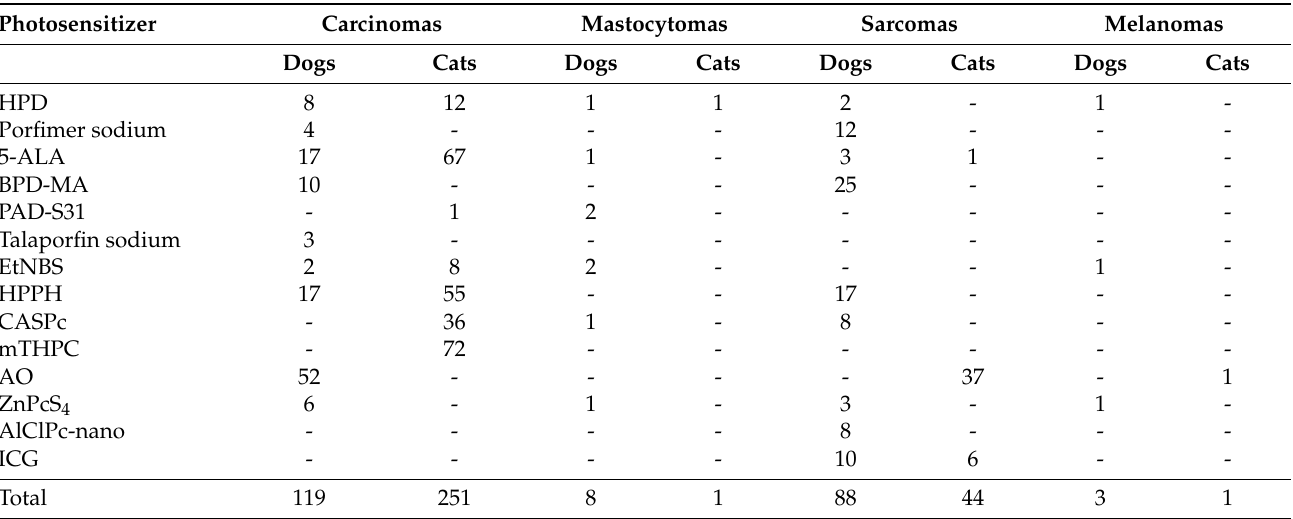
Table 7. Main photosensitizer used in PDT in veterinary